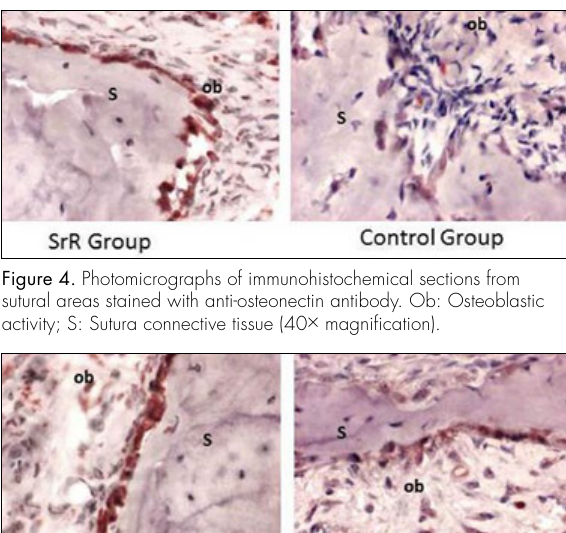
Figure 3. Photomicrographs of histologic sections of sutural areas stained with Hematoxylin and eosin (H&E). Ob: Osteoblastic activity; S: Sutura connective tissue; Cp: Capillary; Nb: New bone (A:5 × , B:10 × , C:20 × , D:40 ×